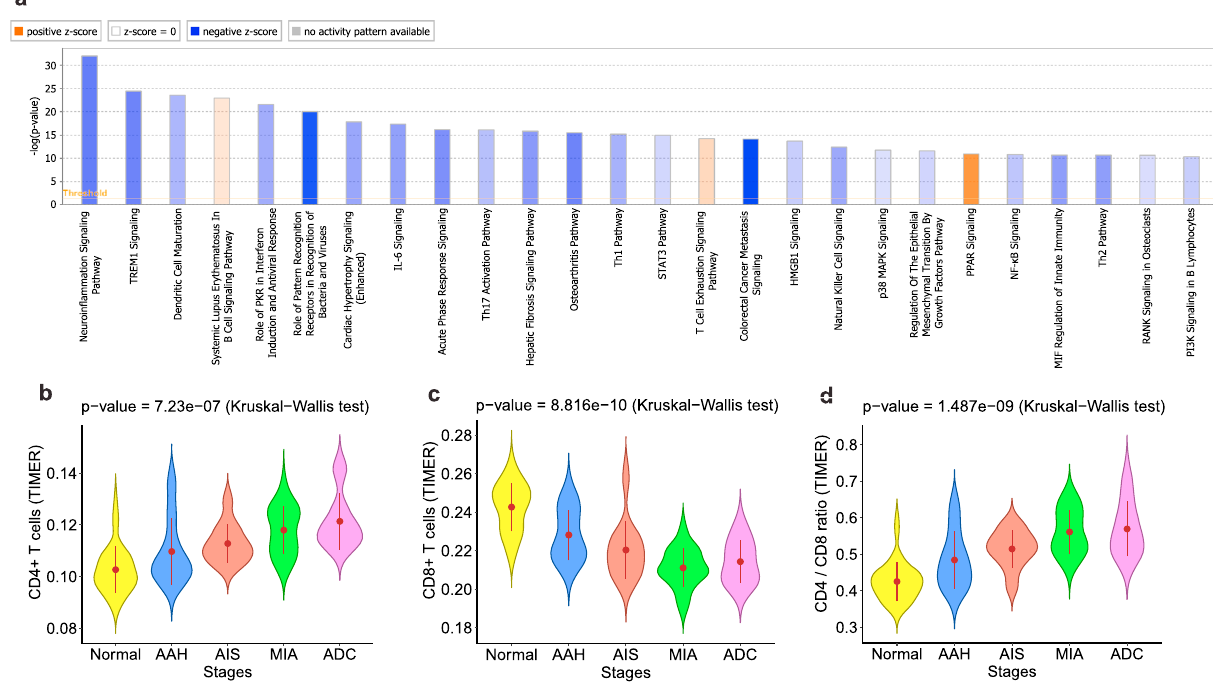
Fig. 2 Immune landscape from preneoplasia to invasive lung adenocarcinoma. a Signi fi cantly enriched functional pathways based on the 291 differentially expressed genes by Ingenuity Pathway Analysis (IPA ® ; Ingenuity Systems) software. Pathways with – log ( p -value) > 10 ( p -values are obtained from Fisher ’ s right-tailed exact test) and an absolute z -score > 0.5 are shown. Pathways that were predicted to be inhibited (negative Z scores) in later stages are in blue and pathways that were predicted to be activated (positive Z scores) in later stages are in orange. The heights of the bars indicate the signi fi cance of the enrichment ( − log ( p -value)) and the scales of the orange or blue colors represent the predicted directionality. Fractions of immune cells including CD4 + T cells ( b ), CD8 + T cells ( c ), and CD4/CD8 ratio ( d ) were estimated using TIMER based on the gene expression using nCounter PanCancer Immune Pro fi ling Panel. Error bars indicate 95% con fi dence intervals and solid point represent mean value in each stage. The difference of cell fraction among different stages was evaluated using two-sided Kruskal – Wallis H test. Data from 38 patients was used including NL (normal lung tissue), AAH (atypical adenomatous hyperplasia), AIS (adenocarcinoma in situ), MIA (minimally invasive adenocarcinoma), and ADC (invasive adenocarcinoma). (Source data is provided as a source data fi